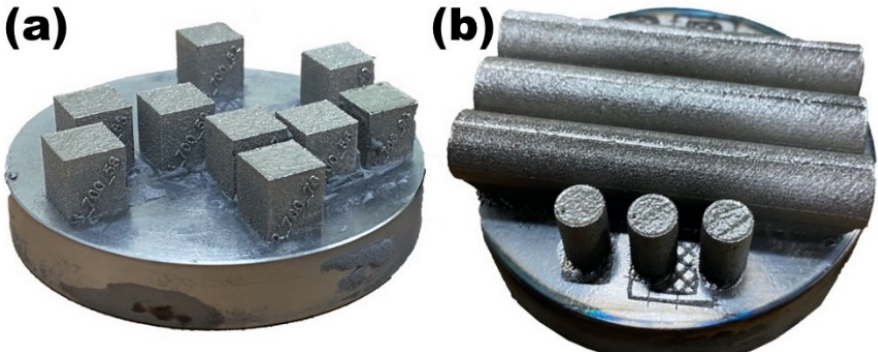
Figure 2. The samples fabricated by L-PBF for ( a ) microstructural characterization and ( b ) tensile tests.